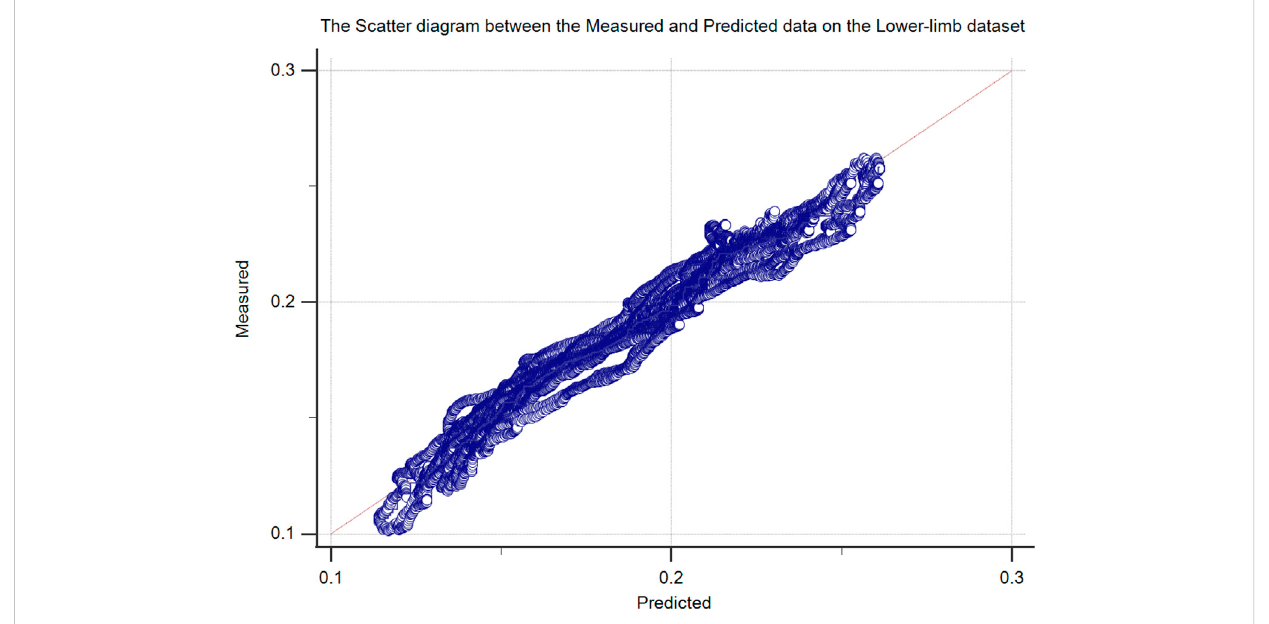
FIGURE 7 The scatter plot of the proposed method (measured vs. predicted force data) lower-limb test dataset (50% hold-out